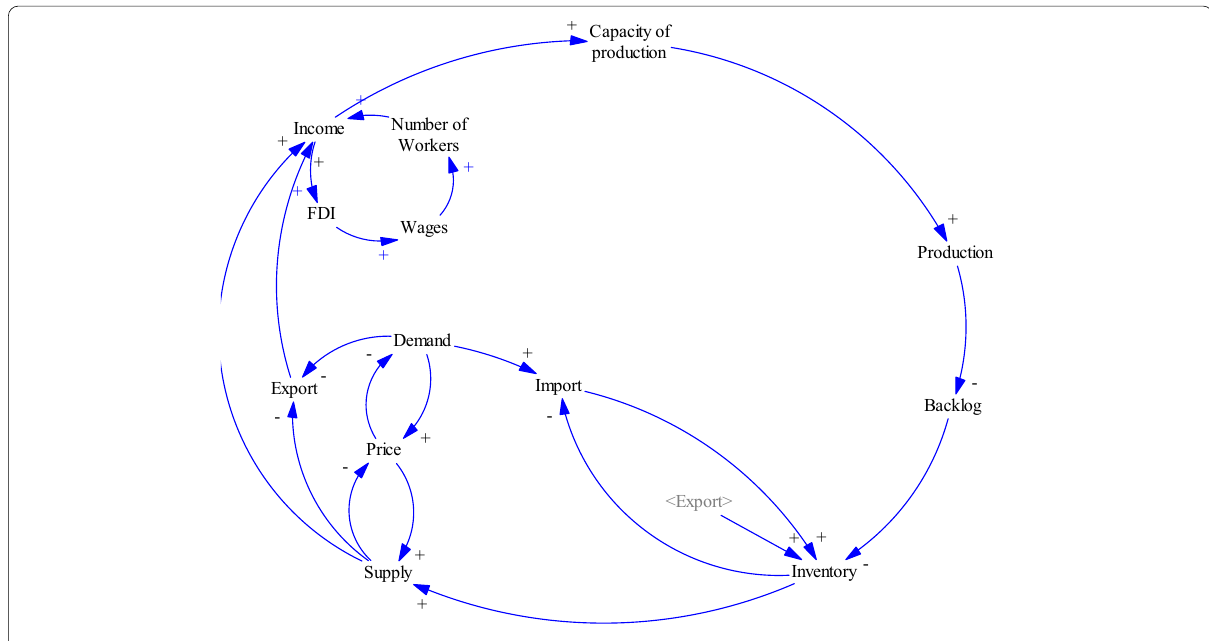
Fig. 5 Relationships of the income variable with other subsystems of the model